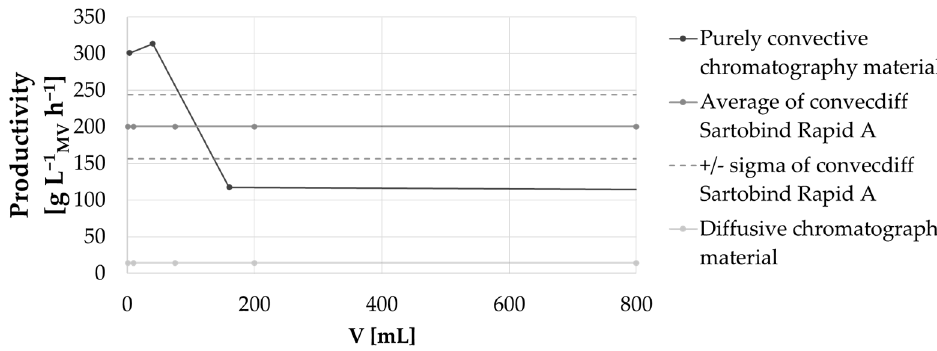
Figure 10. Productivity as a function of membrane/column volume for different categories of chromatographic materials. For the convecdiff membrane, an average value from this study is shown, as well as the range of the obtained productivities.